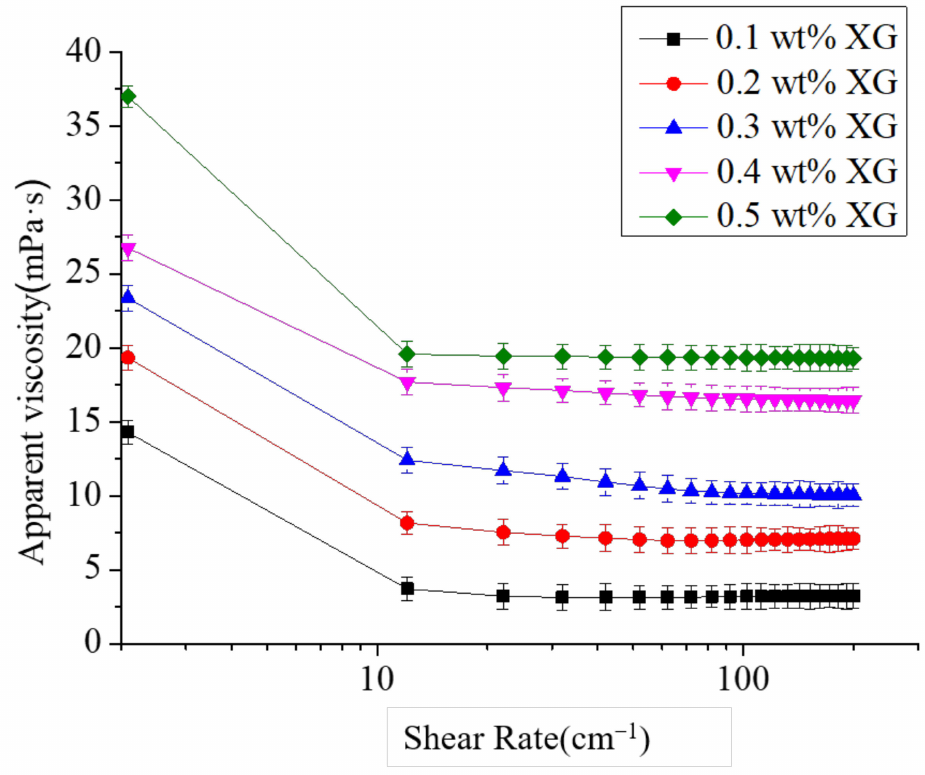
Figure 3. Effect of the different XG concentrations (0.1 wt%, 0.2 wt%, 0.3 wt%, 0.4 wt%, and 0.5 wt%) on the apparent viscosity of CaCO 3 S/O/W